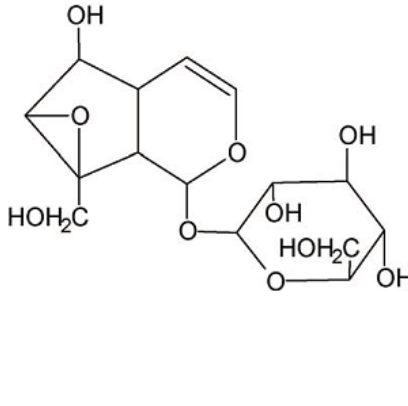
Figure A1. The chemical structure of catalpol. Catalpol, an iridoid glucoside extracted from the traditional Chinese herbal medicine, Rehmannia glutinosa , with a small molecular weight of